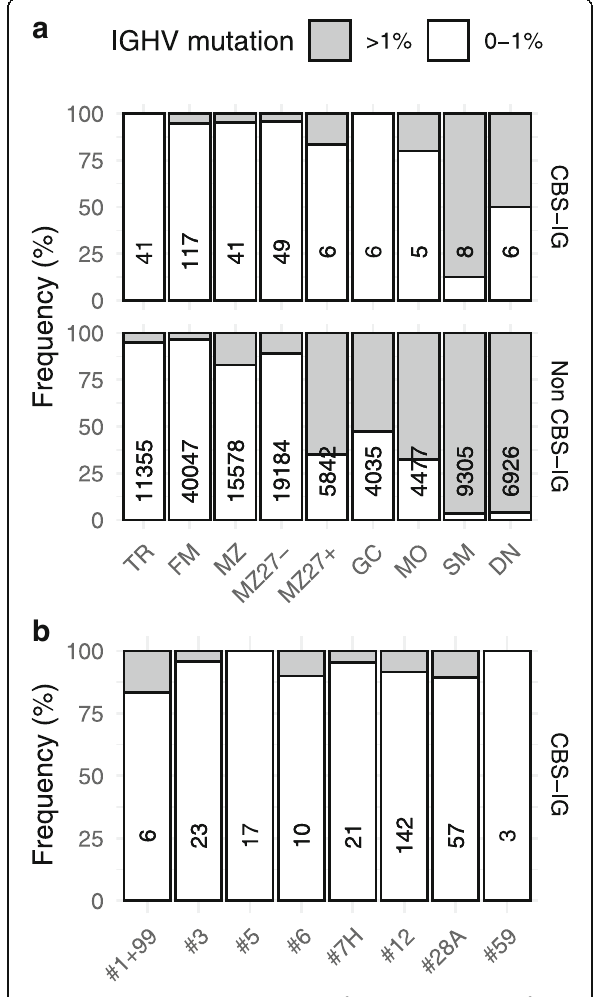
Fig. 3 SHM in CBS-IG rearrangements of s-BCS. a . Frequency of mutated and unmutated rearrangements in CBS-IG and in non- stereotyped rearrangements (non CBS-IG) in the different s-BCS as indicated. b Frequency of mutated and unmutated CBS-IG rearrangements stratified according to CLL stereotype subsets. Numbers in the boxes indicate the total number of clones